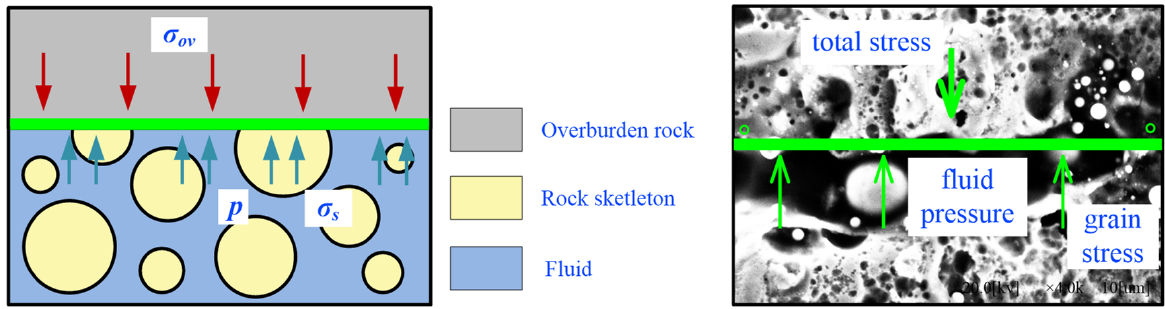
Figure 13. Schematic diagram of the stresses acting on an arbitrary section during seepage.